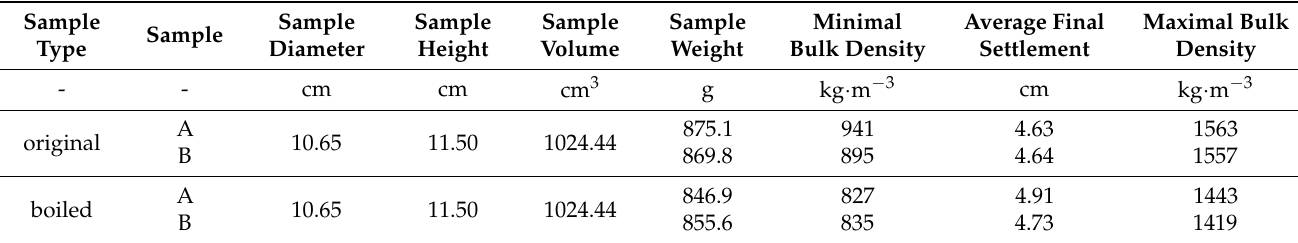
Table 2. Parameters of density tests.